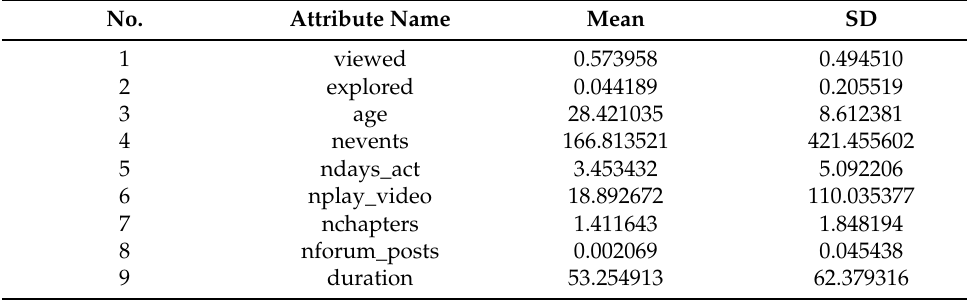
Table 2. The descriptive statistics about the attributes of the model.